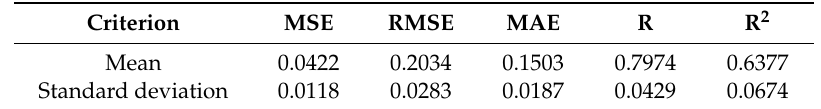
Table 4. Mean and standard deviation of the performance evaluation parameters of the hybrid ANN–ABC method in estimating apple firmness on the spectral data around the wavelength range from 875 nm at 1000 iterations.